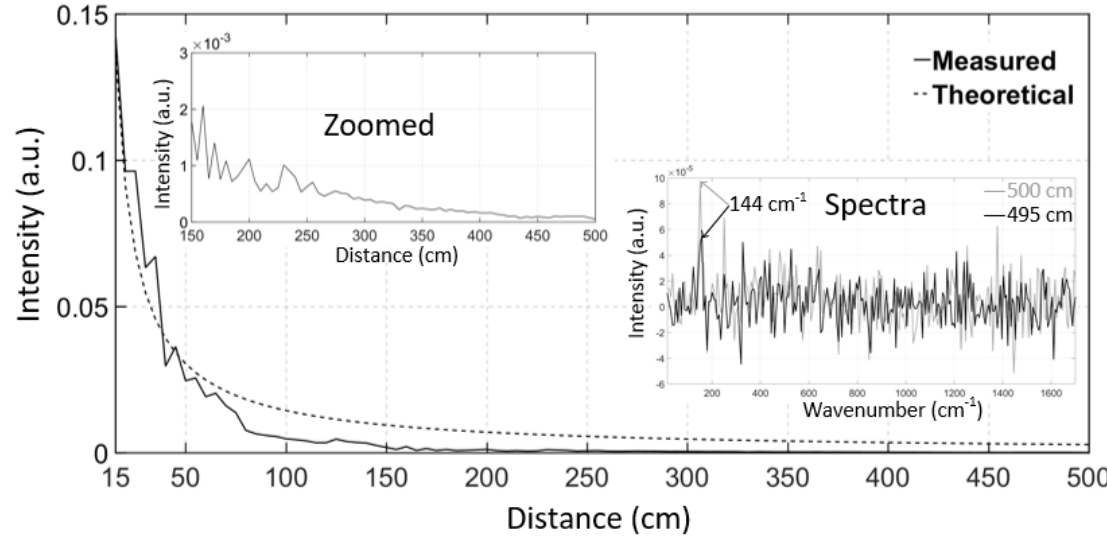
Figure 9. Intensity of the 144 cm −1 Raman peak of TiO 2 as a function of distance, from 15 cm to 500 cm (solid line), and a theoretical curve based on the radar equation (dashed line) and Raman spectra at distances of 495 cm and 500 cm.